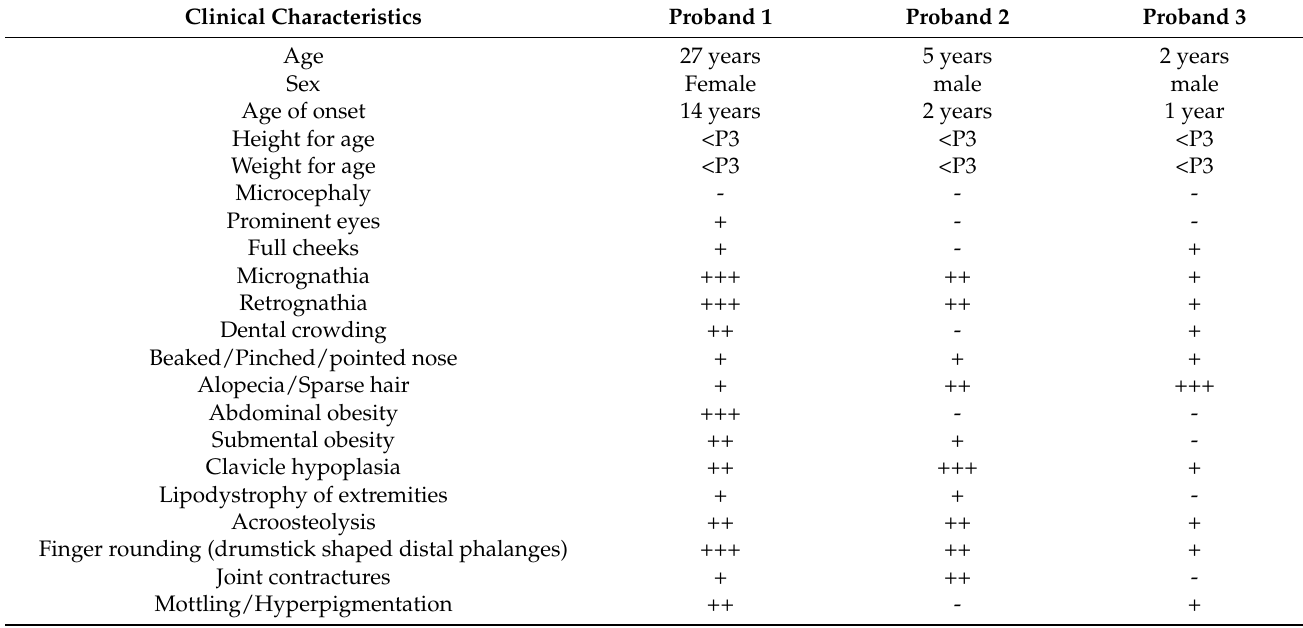
Table 1. Clinical characteristics of the three patients with MADA investigated herein. Clinical